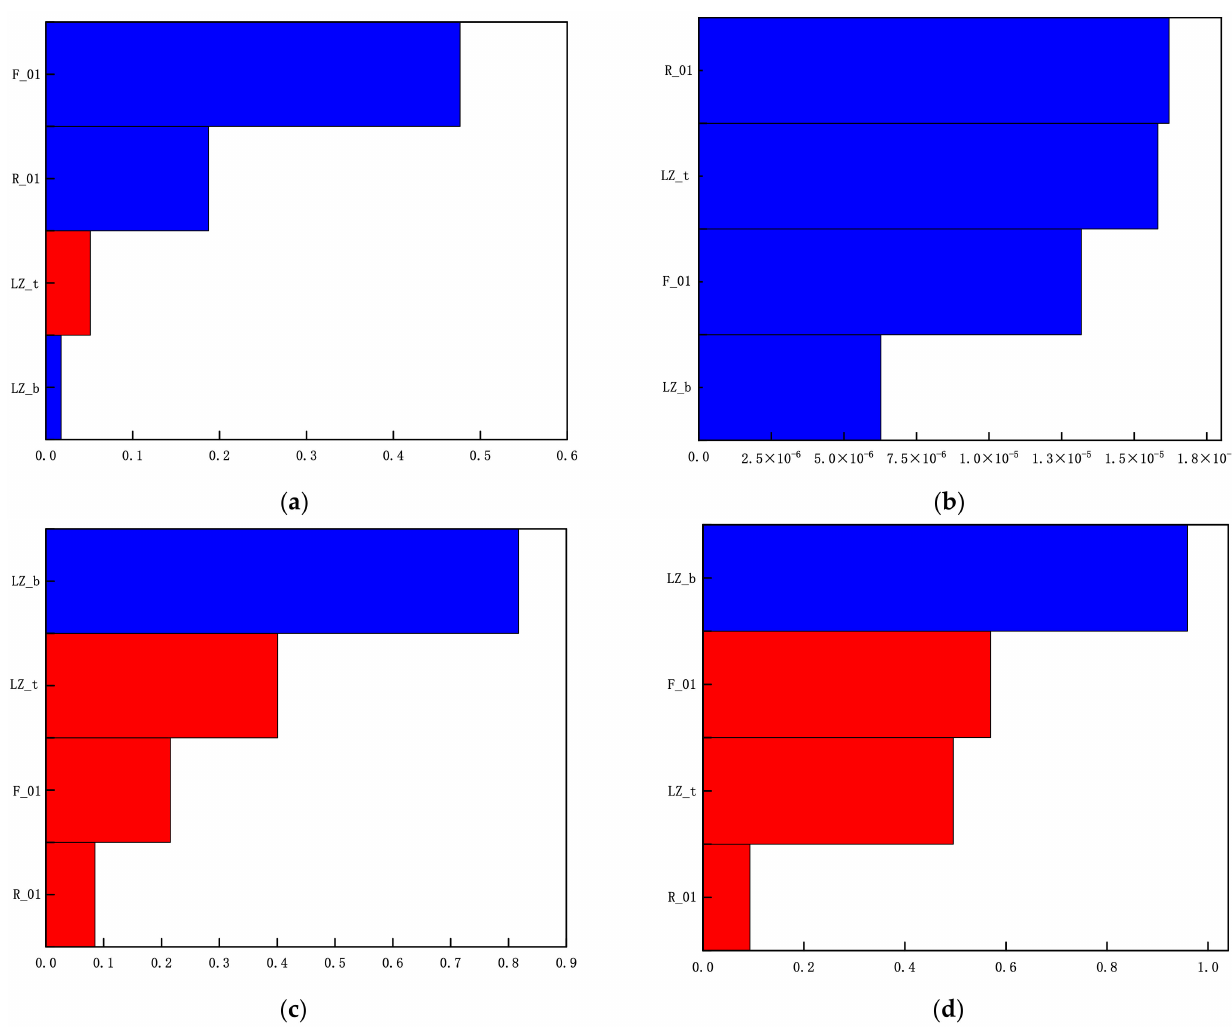
Figure 14. Local effect diagram of each variable and response. ( a ) Frequency local effect diagram. ( b ) Mass Local Effect diagram. ( c ) Local effect diagram of stress in over one side deep pit condition. ( d ) Local effect diagram of forward braking